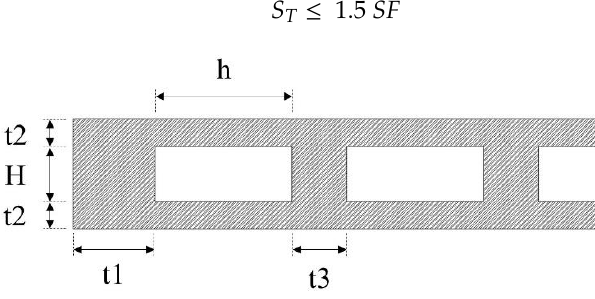
Figure 3. The simplified design used to assess the proposed design.